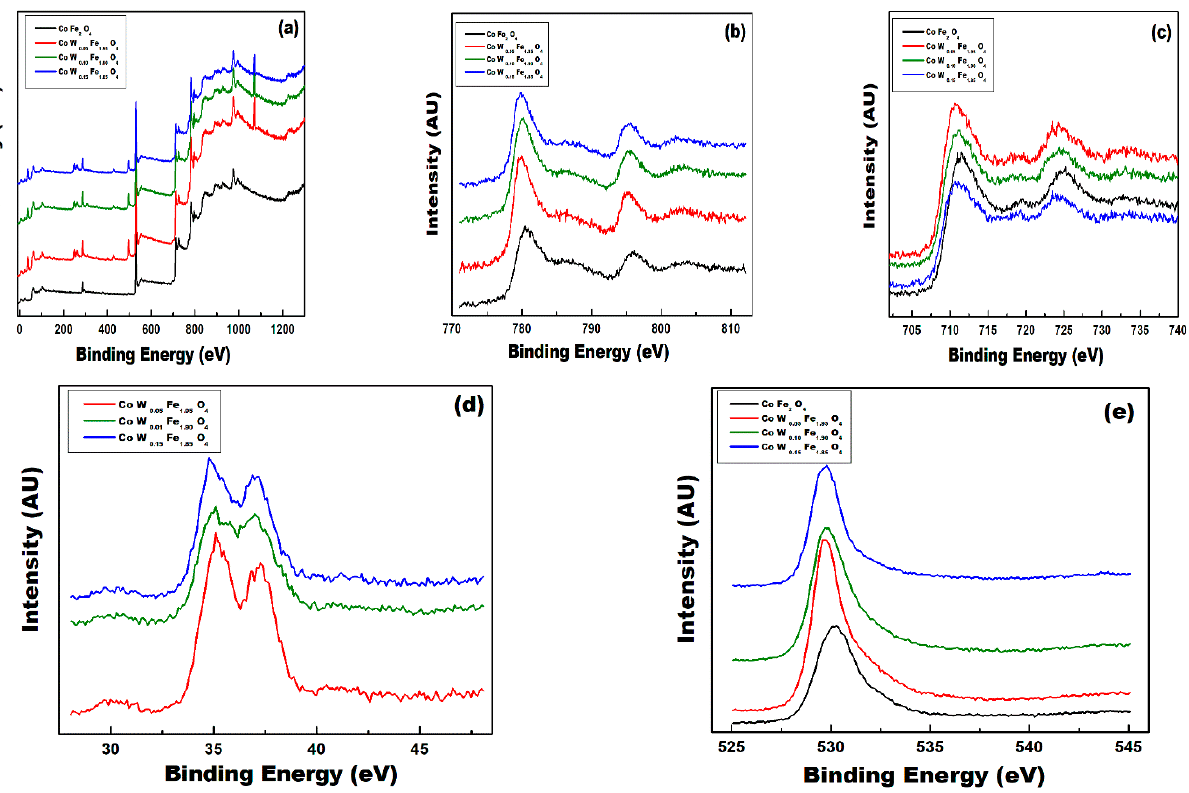
Figure 9. ( a ) Binding energy survey, high resolution XPS spectra of ( b ) Co2p, ( c ) Fe2p, ( d ) W4f, and ( e ) O1s of CoFe 2 O 4 (red colure), 0.5% W-CoFe 2 O 4 (blue colure), 0.1% W-CoFe 2 O 4 (olive colure), and 0.15% W-CoFe 2 O 4 (wine colure) of W-substituted CoFe 2 O 4 nanoparticles.